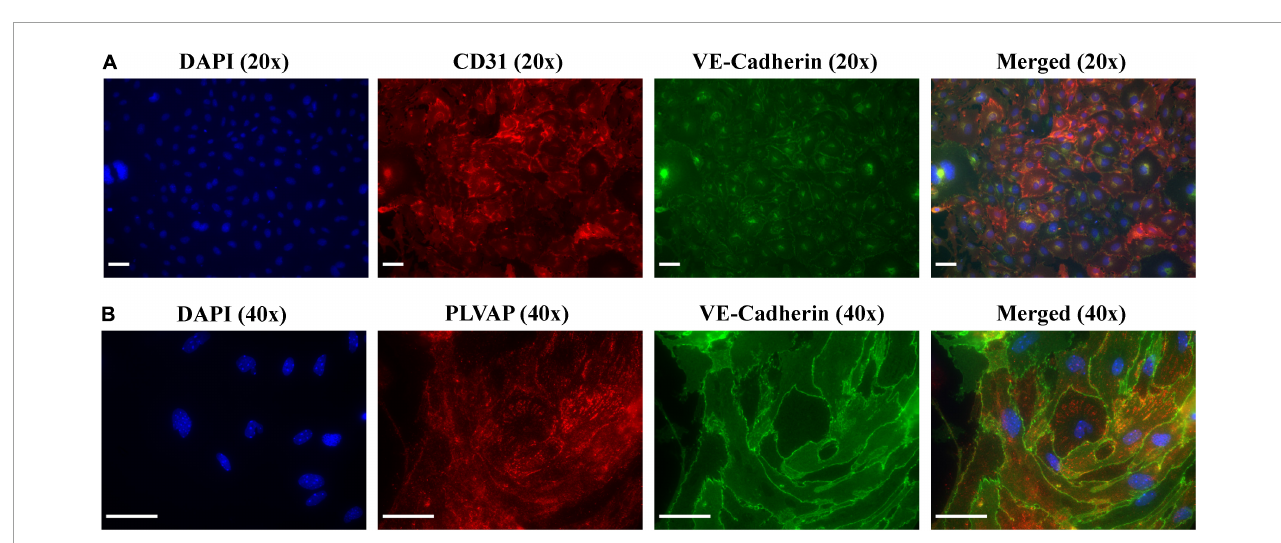
FIGURE4 Immunofluorescent imaging (IF) and characterization of MRPECs 10 days post-isolation. Representative IF-photomicrographs of MRPEC monocultures 10 days post-isolation. (A) Nuclear staining DAPI (panel 1, blue), PECAM1+ staining (panel 2, red), VE-cadherin+ staining (panel 3, green), and merged (panel 4); all representative images in panel (A) were taken at 20 × magnification. (B) Nuclear staining DAPI (panel 1, blue), PLVAP+ staining (panel 2, red), VE-cadherin+ staining (panel 3, green), and merged (panel 4); all representative images in panel (B) were taken at 40 × magnification. All representative images were obtained on an EVOS-M5000 fluorescence microscope system and merged by overlay in FIJI (ImageJ) software. N = 4–6 isolations. Scale bars, 50 µ